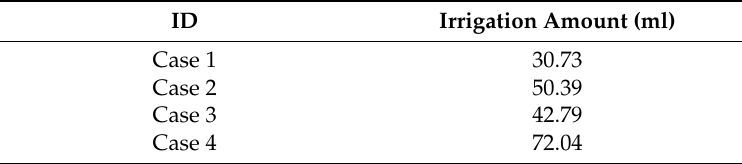
Table 12. Irrigation amount of the entire pot